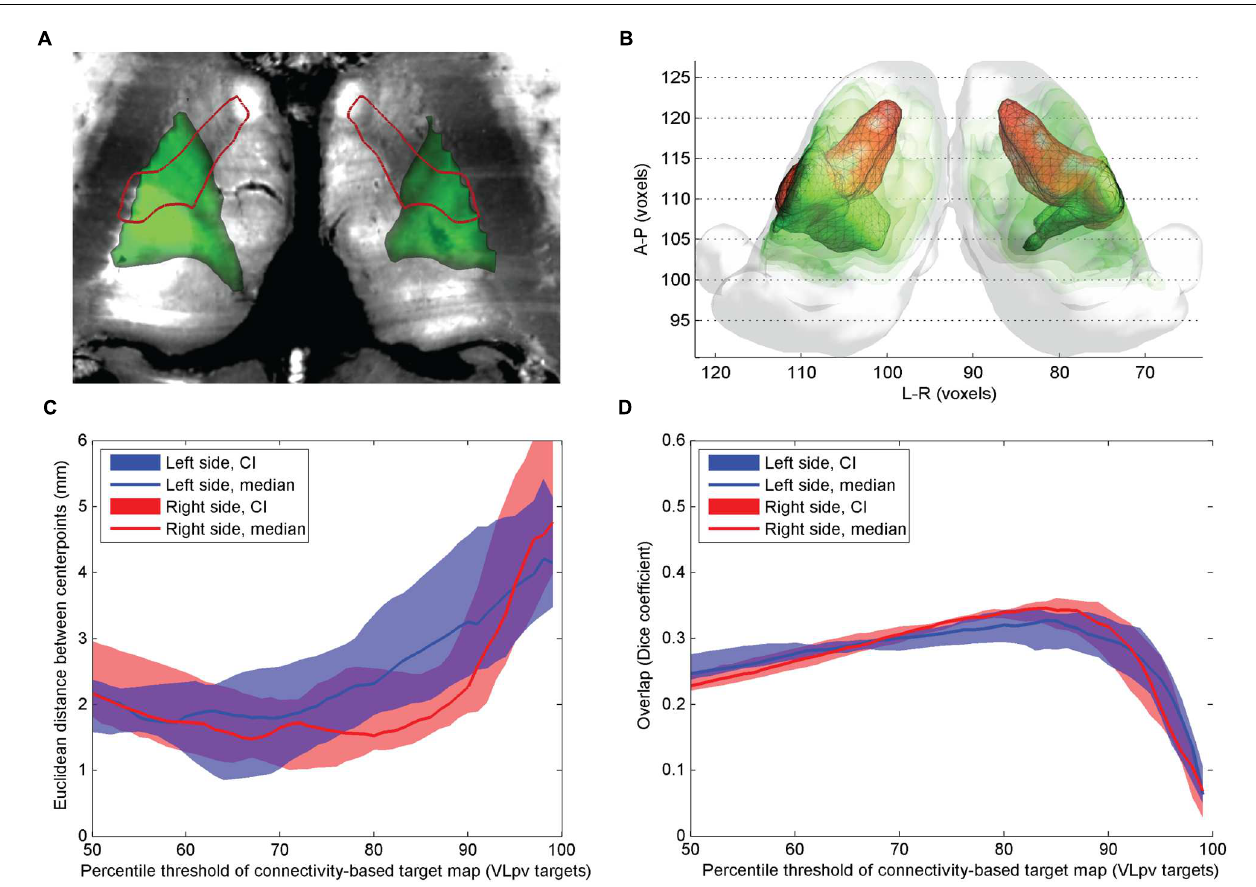
FIGURE 1 | Comparison of atlas and CBTs of the VL pv nucleus. (A) Cross-sectional image derived from histological sections, in standard space (Big Brain Atlas, Amunts et al., 2013) with VL pv overlaid (red outlines) and the CBT (green color scale) ; (B) 3D visualization of the CBT and atlas targets: connectivity-based targets were visualized in green color with different opacities reflecting to the summed probability across the study population (50–95th percentile range) while the VL pv was depicted in red 3D mesh ; (C) Euclidian distance of the center-of-gravity of the CBT to the atlas based target: dependency on the applied threshold values; (D) volumetric overlap with atlas based targets: dependency on the applied